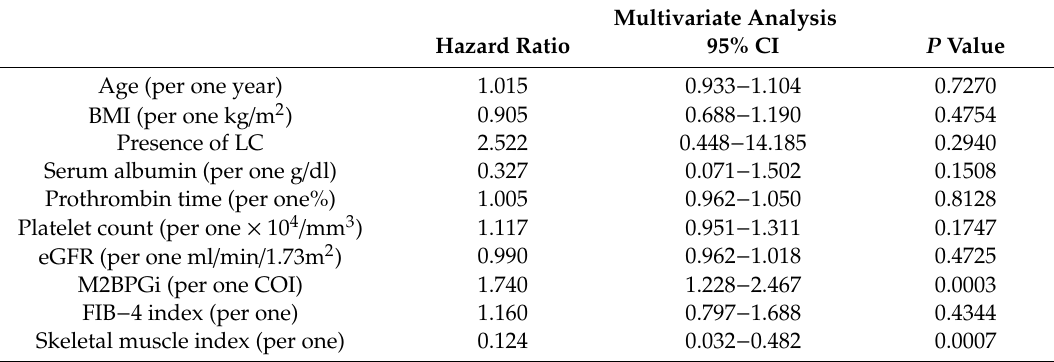
Table 3. Multivariate analyses of factors linked to the low grip strength for male cases. Multivariate Analysis